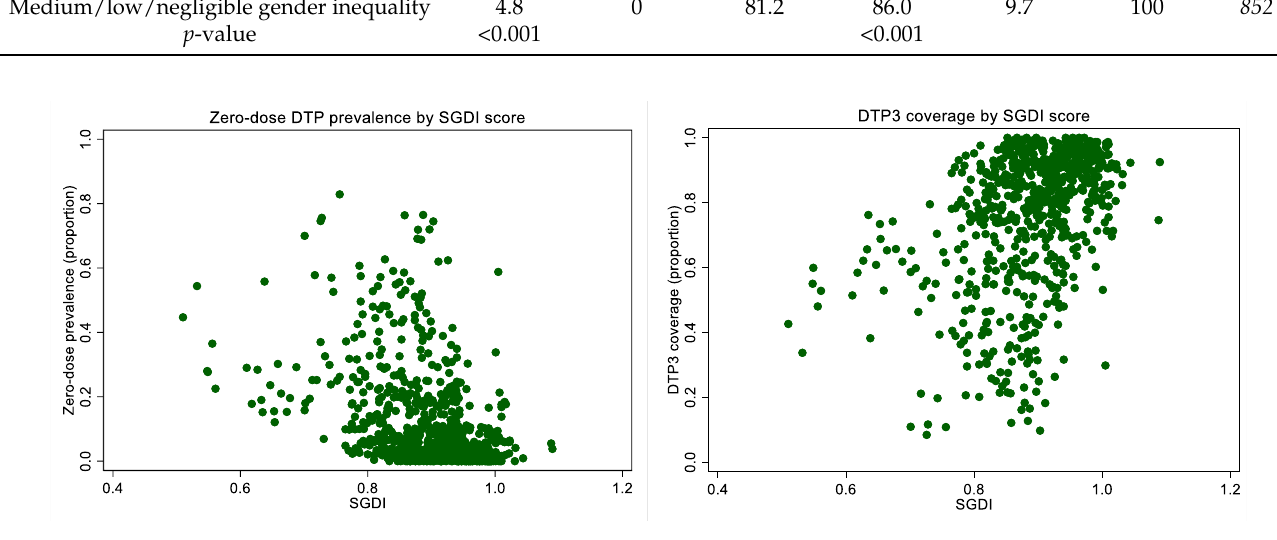
Figure 2. Prevalence of zero-dose DTP and DTP3 immunization coverage by continuous SGDI score, most recent year of available data.